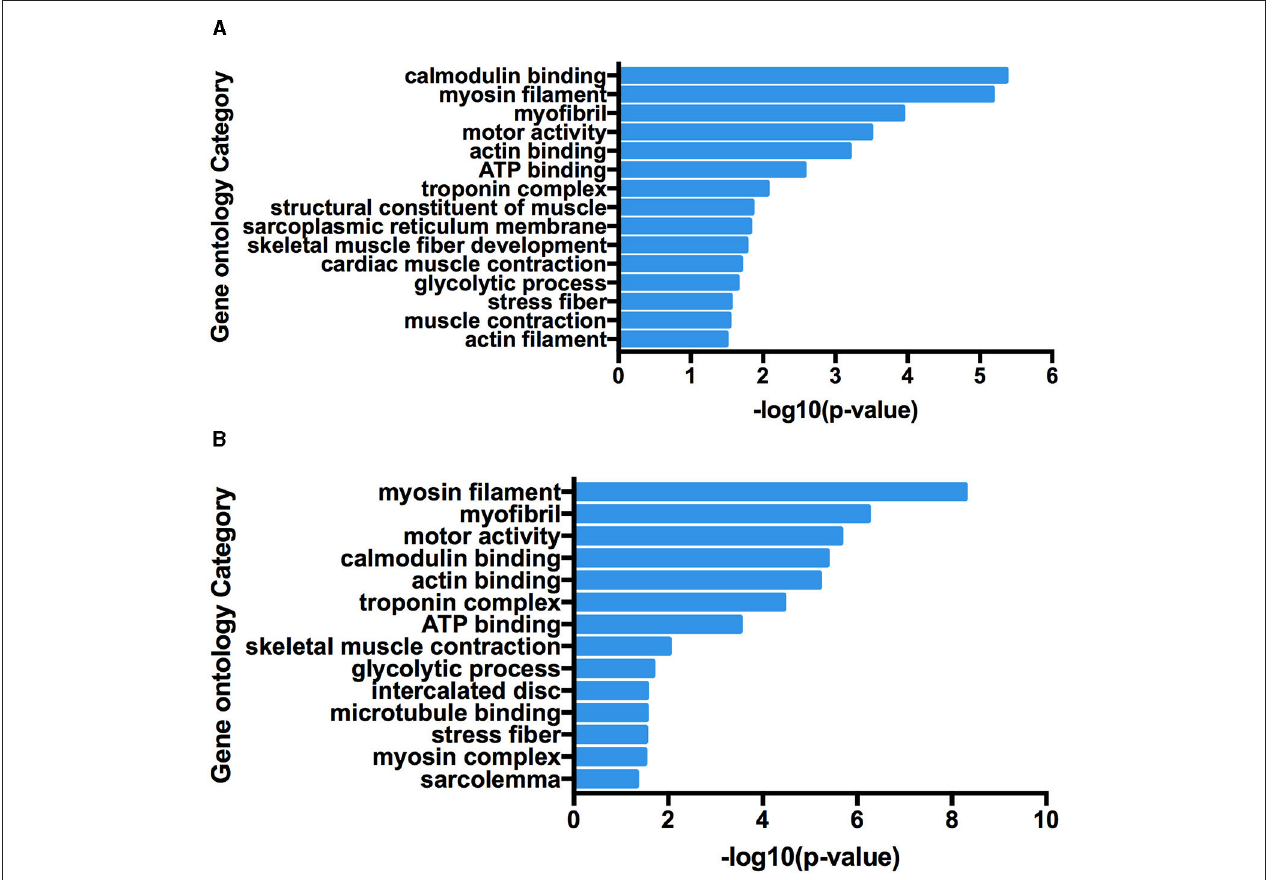
FIGURE 2 | Functional map of differentially expressed genes enriched for GO terms. All categories were statistically significant ( p < 0.05). (A) Gene Ontology terms enriched in 5 ′ parental genes involved in forming chimeric RNAs. (B) Gene Ontology terms enriched in 3 ′ parental genes involved in forming chimeric RNAs.